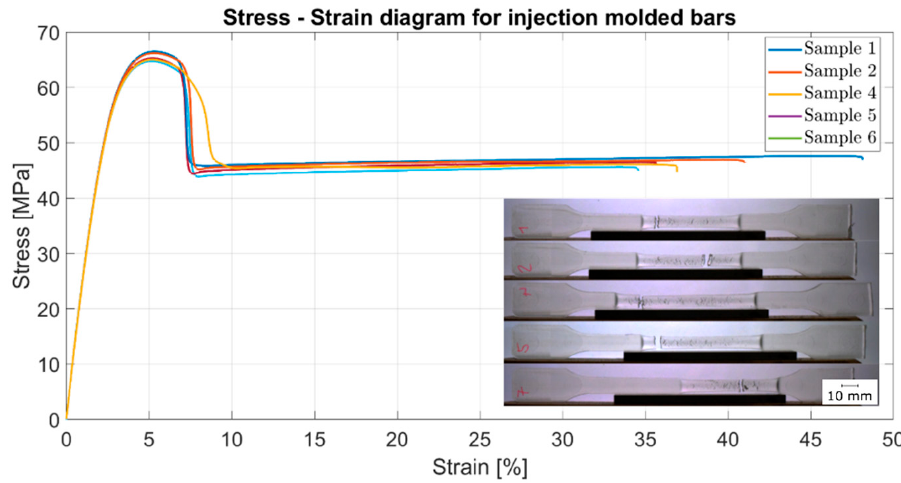
Figure 11. Tensile test results according to DIN EN ISO standard 527-1 of injection-molded samples. Table 4. Average result with standard deviation of tensile test of injection-molded samples. Yield Stress σ y Yield Strain ε